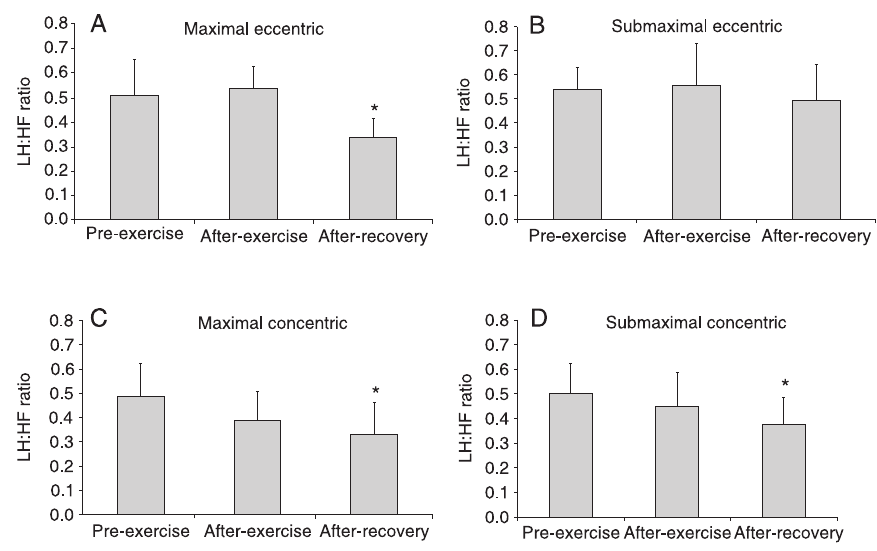
Figure 1. LF:HF ratio of eccen- tric and concentric